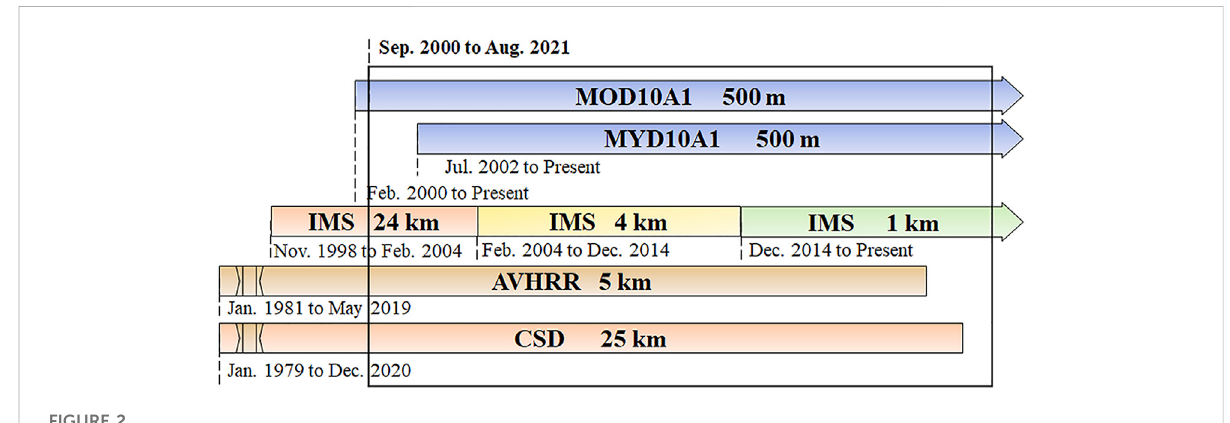
FIGURE 2 Remote sensing data used in this